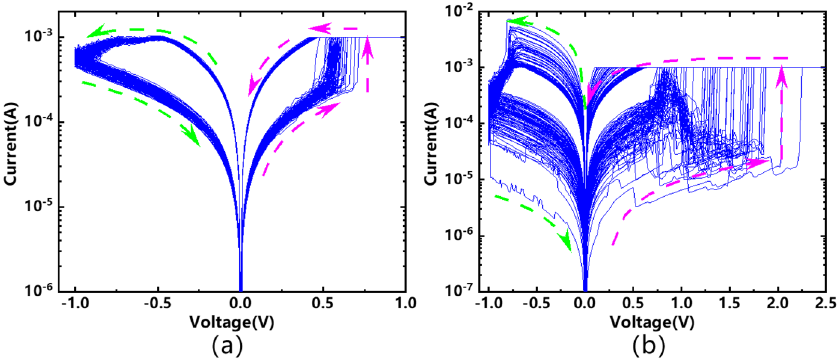
Figure 2. 100 consecutive I-V curves with 1 mA CC and − 1 V reset stop voltage of ( a ) Pt/TaO x :Al/TiN RRAM and ( b ) Pt/TaO x /TiN RRAM.